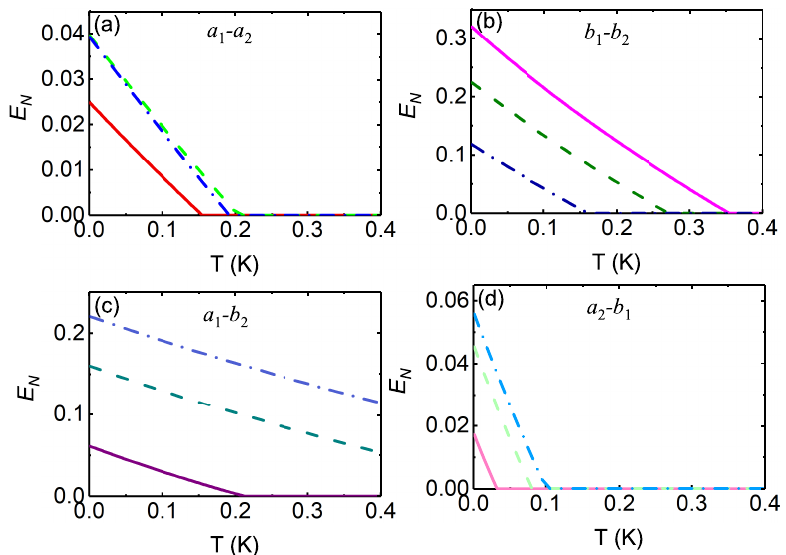
Figure 6. Plots of logarithmic negativity E N as functions of the environment temperature T for φ = 0 (solid lines), π /2 (dashed lines), and π (dash-dotted lines). Panel ( a ) represents the entanglement between the two cavity modes, panel ( b ) represents the entanglement between the two mechanical modes, panel ( c ) corresponds to the entanglement between the cavity mode a 1 and mechanical mode b 2 , and panel ( d ) corresponds to the entanglement between the cavity mode a 2 and mechanical mode b 1 . The other parameters are the same as those in Figure 3, except J 12 /2 π = J 21 /2 π = 0.15